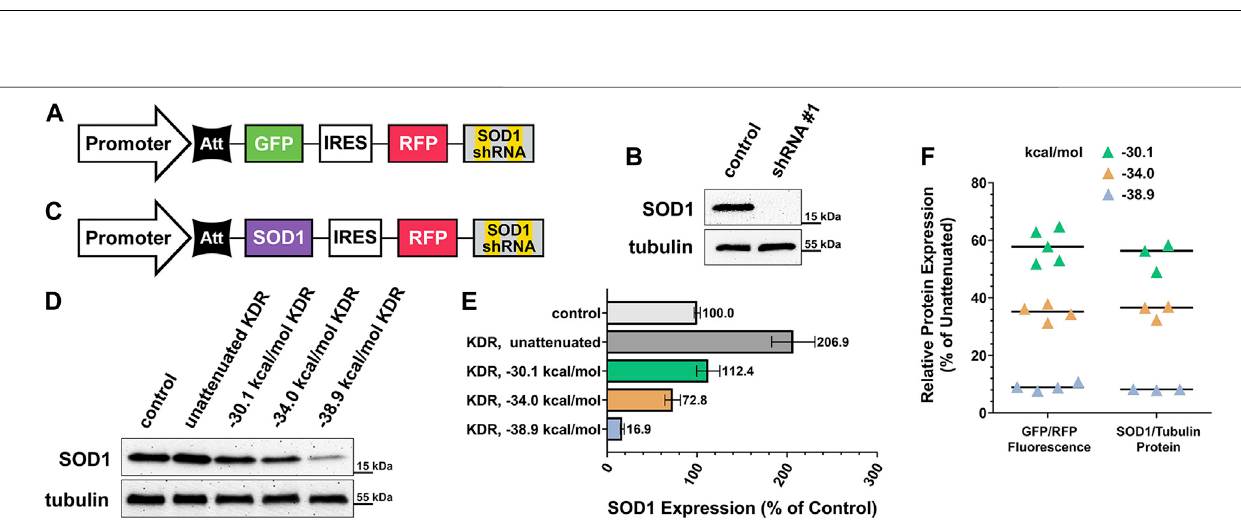
FIGURE 4 | Practical application of knockdown-replacement strategy using pKDR-SOD1 virus. (A) SOD1 gene speci fi c shRNA potency was validated using lentivirus carrying SOD1 shRNA, but GFP coding sequence in rescue position rather than SOD1. (B) Cell lines were created using SOD1-KD virus as previously described, then evaluated by western blot. Comparison of KD condition (equivalent to background noise) to un-transduced control HEKs con fi rms complete shRNA ef fi cacy. (C) GFP gene was then exchanged for SOD1 and a range of graded-expression constructs were created, this included un-attenuated rescue expression (no hairpin) and three levels of increasing attenuator potency ( − 30.1, − 34.0, and − 38.9 kcal/mol). (D) Cell lines were created for each of these 4 conditions, then SOD1 expressionwasevaluatedbywesternblotandquanti fi edin (E) .Un-attenuatedSOD1expressionwasfoundtobeovertwiceashighasbaselineexpression,whereasthe − 30.1 kcal/molconstructmostcloselymatchedendogenousexpression. (F) Plasmid-basedratioofGFP “ rescue ” /RFPinternalcontrol fl uorescencetovirallyexpressed SOD1 rescue/endogenous tubulin protein is functionally identical for each attenuator tested. At − 30.1 kcal/mol mean GFP expression was 58.05% of control, SEM ±2.58,95%CI±5.05%,andSOD1mean=54.56%,SEM±2.85.At − 34 kcal/molmeanGFPexpressionwas34.91%,SEM=1.40,95%CI±2.74%,andSOD1mean= 35.27%,SEM±1.46.At − 38.9 kcal/molmeanGFPexpressionwas9.10%,SEM±0.64,95%CI±1.25%,andSOD1mean=8.14%,SEM±0.11.MeansforeachSOD1 attenuation condition fall within the 95% con fi dence interval of their corresponding plasmid-based in vitro measurement.